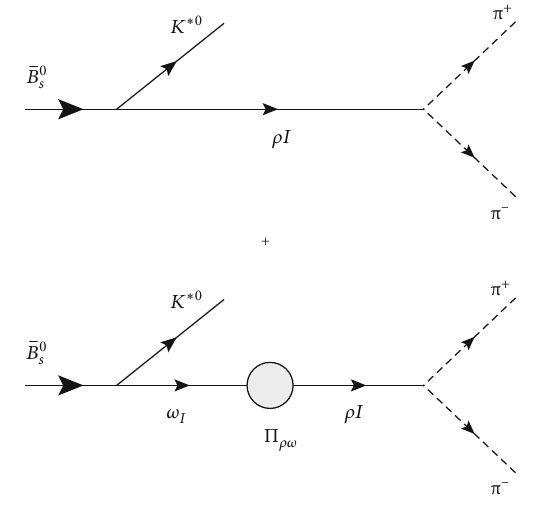
⟶ π + π − K ∗ 0 decay with the ρ s